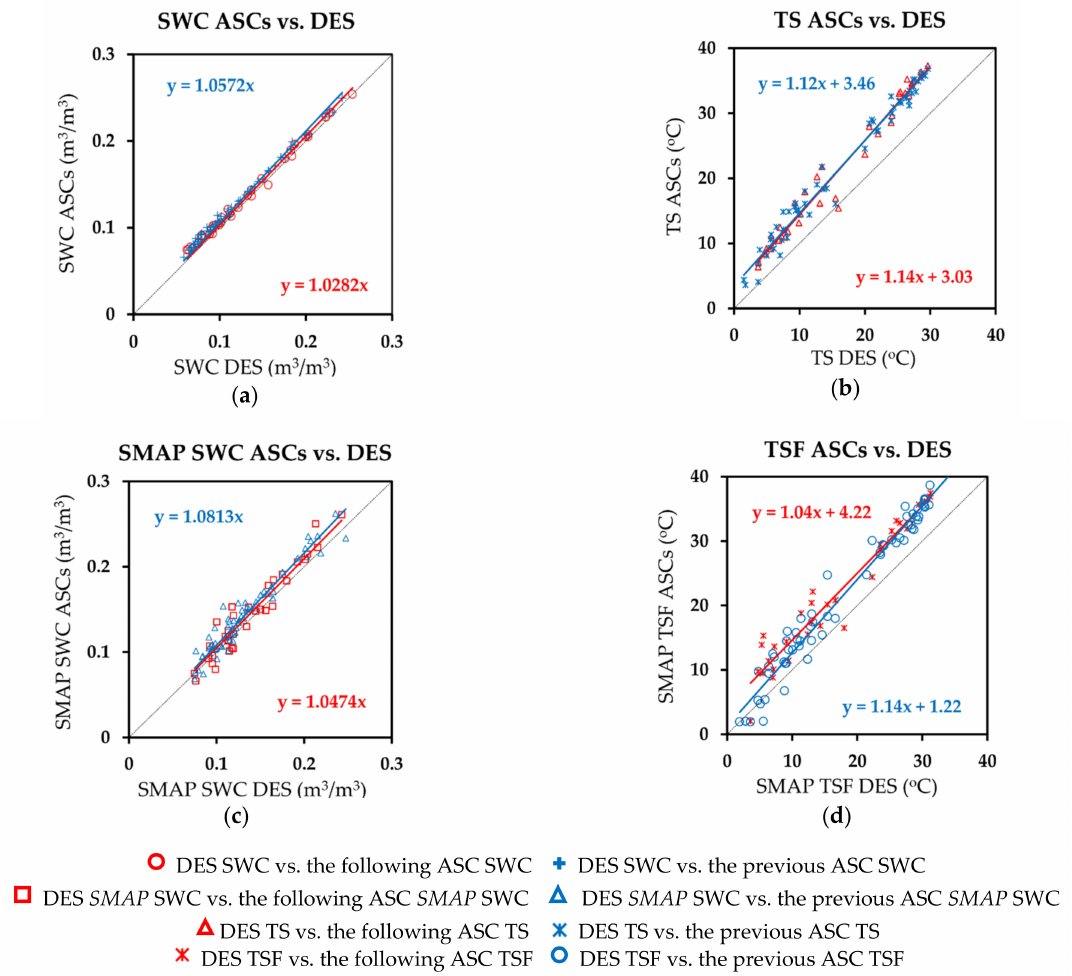
Figure 3. Scattergrams of the values at previous (blue color) and following (red color) ascending versus descending nodes of ( a ) SWC and ( b ) soil temperature (TS) at 5-centimeter depth and ( c ) SMAP SWC and ( d ) SMAP TSF at LWREW from September 2017 to December